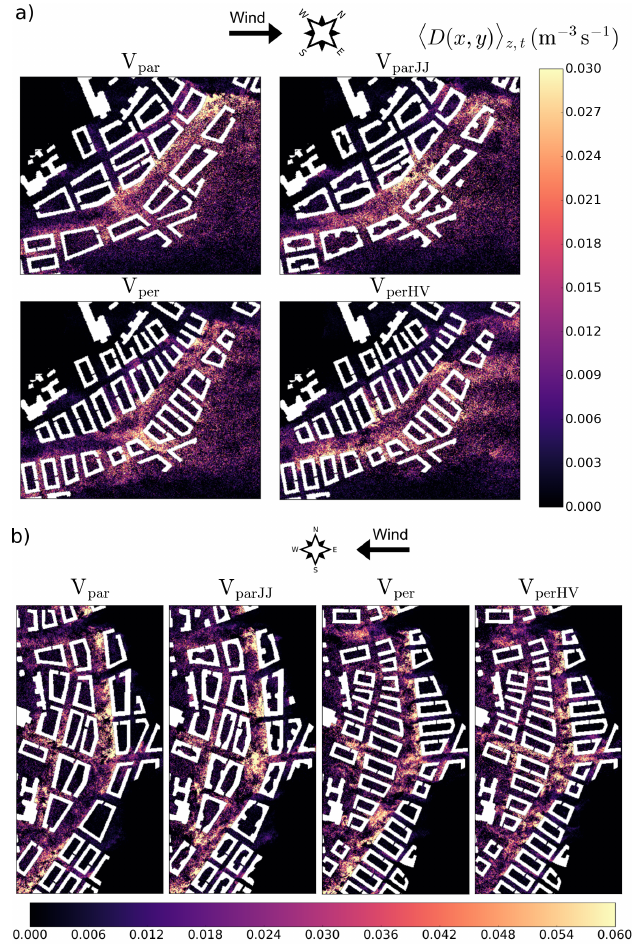
Figure 14. The temporal mean particle dilution rate (cid:104) D ( x , y ) (cid:105) t , z (m − 3 s − 1 ) between z = 1–20 m for the first 60 s after the particle has been switched off: ( a ) general and ( b ) wintry inflow